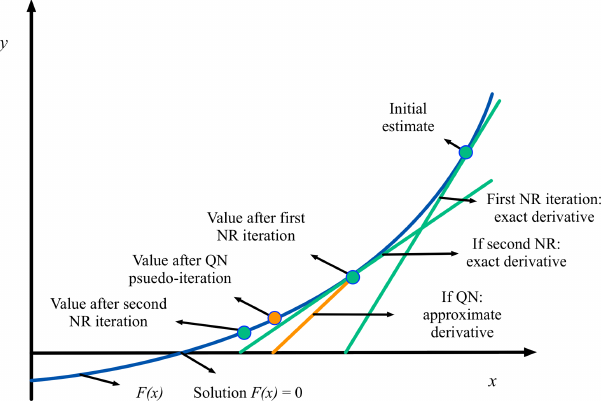
Figure 1. Illustration of application of the QN method (adopted in our work) to find the root of a function of one